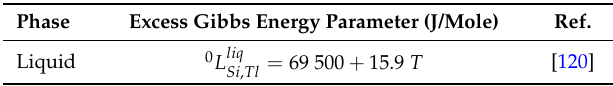
Table 18. Model parameters of the Si-Tl